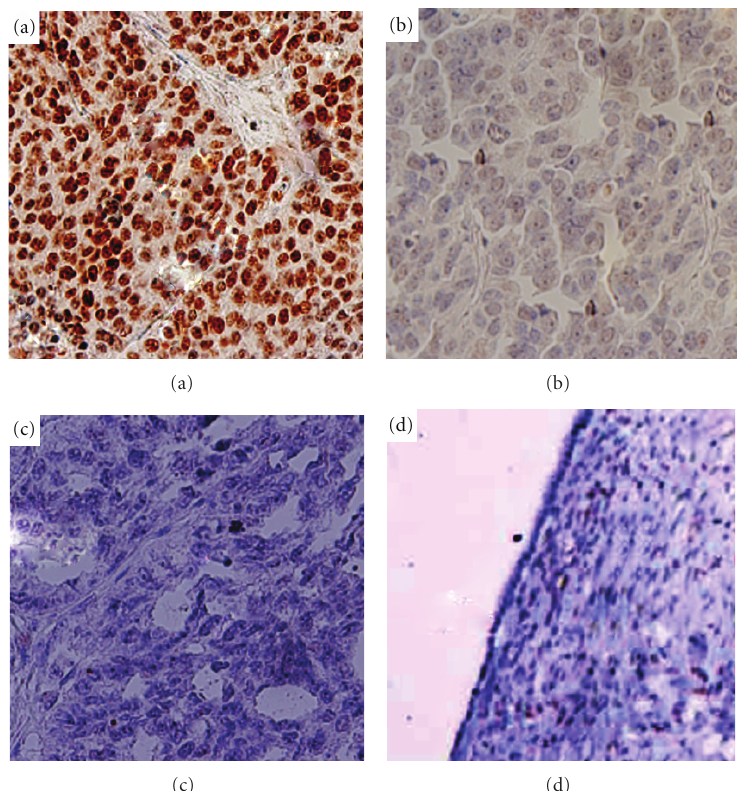
Figure 1: Immunohistochemical staining for RUNX2 in epithelial ovarian cancer and normal ovarian tissues (original magnification × 200). (a) High RUNX2 expression (LI = 96 . 5%) in epithelial ovarian cancer tissues with clinical stage IV. (b) Low RUNX2 expression (LI = 16 . 6%) in epithelial ovarian cancer tissues with clinical stage I. RUNX2 immunoreactivity was predominantly localized in the nuclei of epithelial ovarian cancer cells. (c) Negative control without the primary antibody in epithelial ovarian cancer tissues. (d) Negative RUNX2 expression in normal ovarian